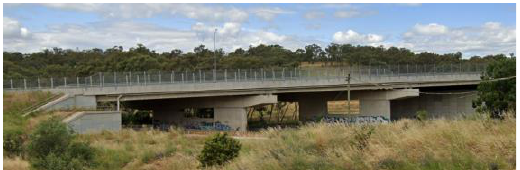
Figure 3. The side view of Kapooka bridge.